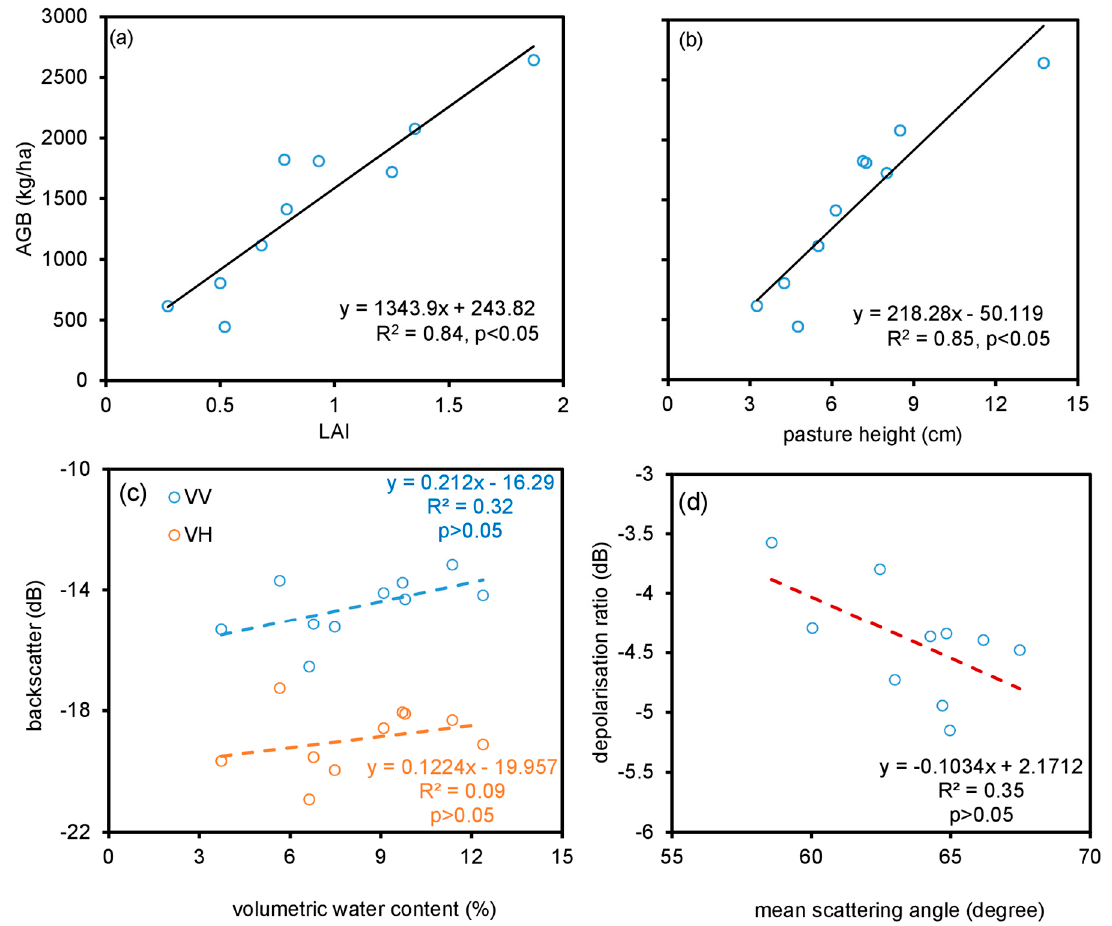
Figure 7. Correlation between: ( a , b ) leaf area index (LAI), pasture height and aboveground biomass (AGB), ( c ) volumetric water content and backscattering coefficients, and ( d ) mean scattering angle and depolarisation ratio.